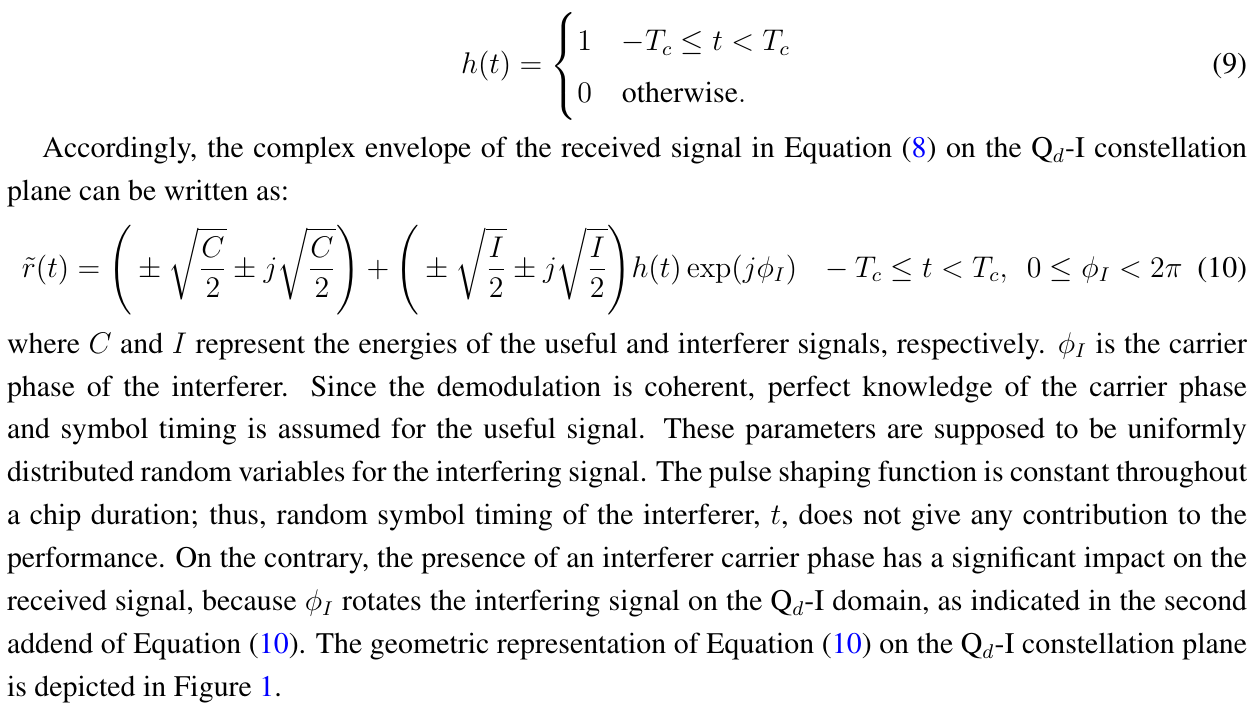
-I domain representation of interferer signal; d